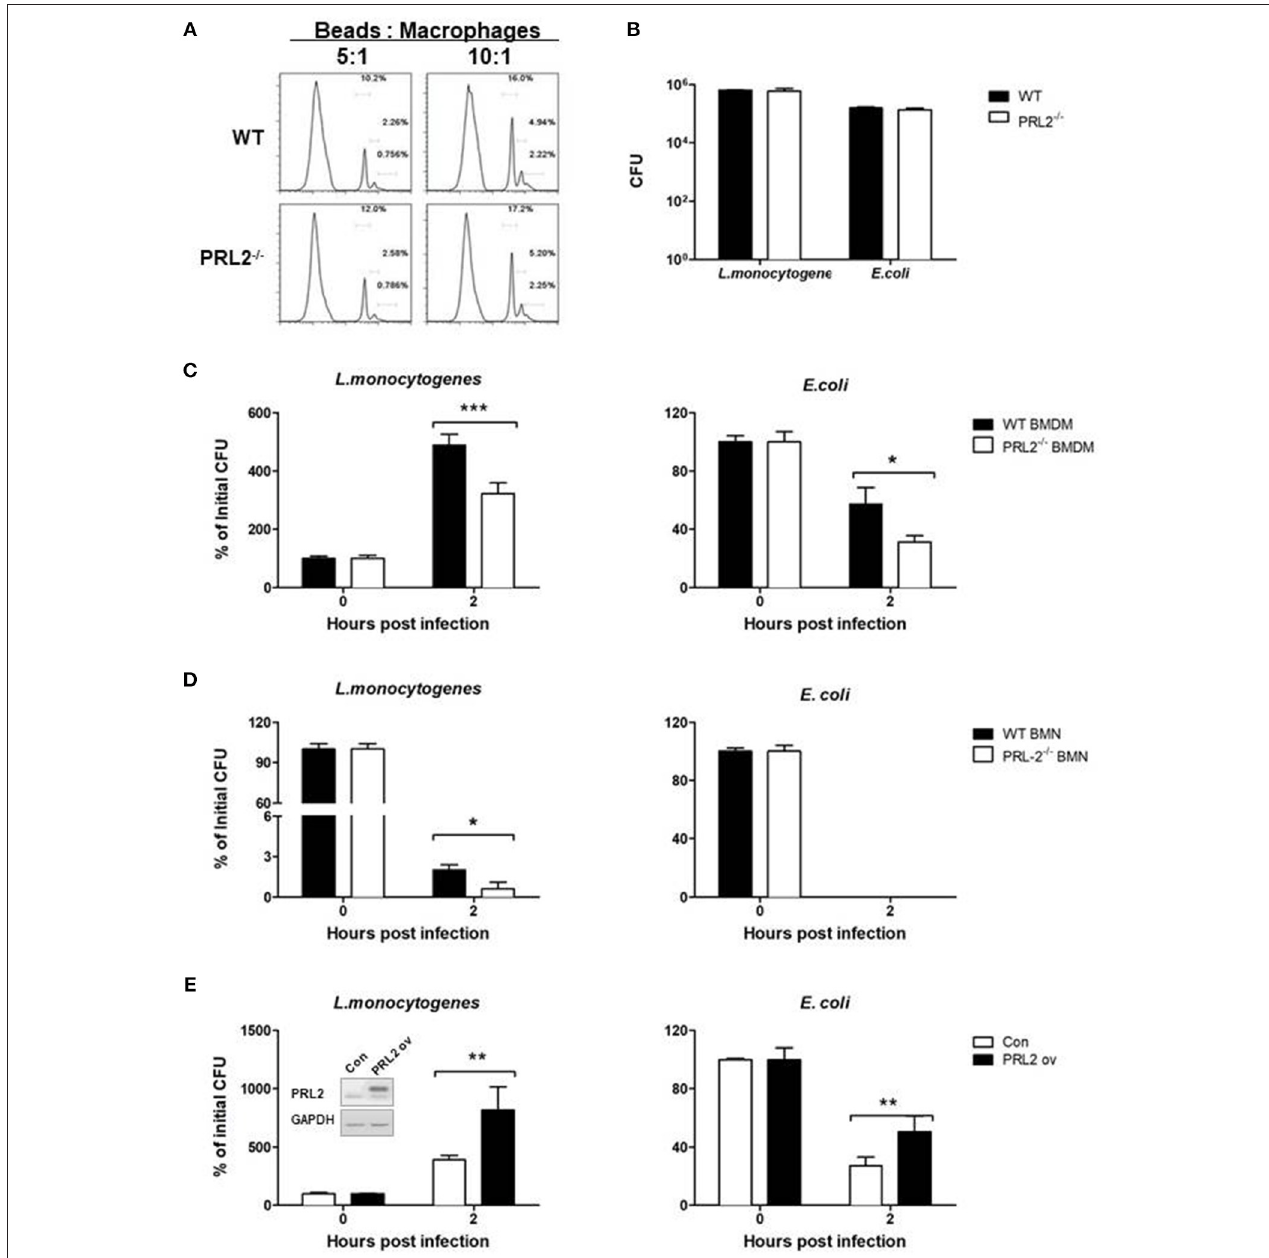
FIGURE 4 | PRL2 negatively regulates bactericidal activity of phagocytes. (A) Bone marrow-derived macrophages (BMDMs) from PRL2 CKO mice and wild-type littermates were incubated with fluorescently labeled 2 µ m beads at a ratio of 5:1 or 10:1 (Beads: cells) for 30min, The phagocytosis function of BMDMs was evaluated by flow cytometer assay. (B) BMDMs from PRL2 CKO mice and wild-type littermates were incubated with Listeria monocytogenes ( L. monocytogenes ) or Escherichia coli ( E. coli ) at MOI 10 (bacteria:cell) for phagocytosis analysis. Surviving intracellular bacteria were determined by colony-forming unit assay. (C,D) BMDMs and bone marrow neutrophils (BMNs) from WT or CKO mice were infected with L. monocytogenes or E. coli at a ratio of 1:1 for 20min. After washing cells were incubated for additional 2h. Bacterial numbers in the cells were determined by colony-forming unit assay. (E) Raw 264.7 cells were transfected with PRL2, or a control plasmid, and incubated with L. monocytogenes or E. coli at a ratio of 1:1 for 20min. After washing cells were incubated for additional 2h. The intracellular bacteria were determined by colony-forming unit assay. Data are pooled from three to four independent experiments. * p < 0.05, ** p < 0.01, *** p < 0.005.